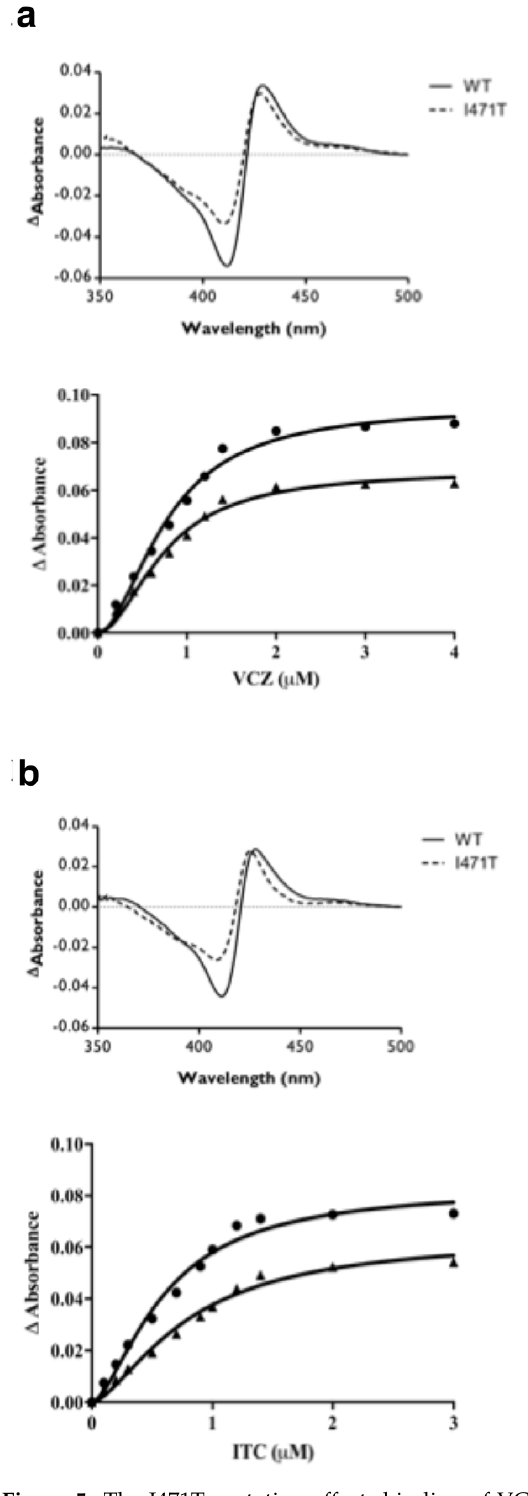
Figure 5. The I471T mutation affects binding of VCZ and ITC to affinity-purified ScLDM6 × His. Difference spectra obtained in the presence of saturating ( a ) VCZ (3 µ M) and ( b ) ITC (3 µ M) with 2 µ M ScLDM6 × His wild-type and ScLDM6 × His I471T are shown on the top of each figure, and the curves for type II binding saturation are shown on the bottom with ScLDM6 × His wild-type (circles) and ScLDM6 × His I471T (triangles).